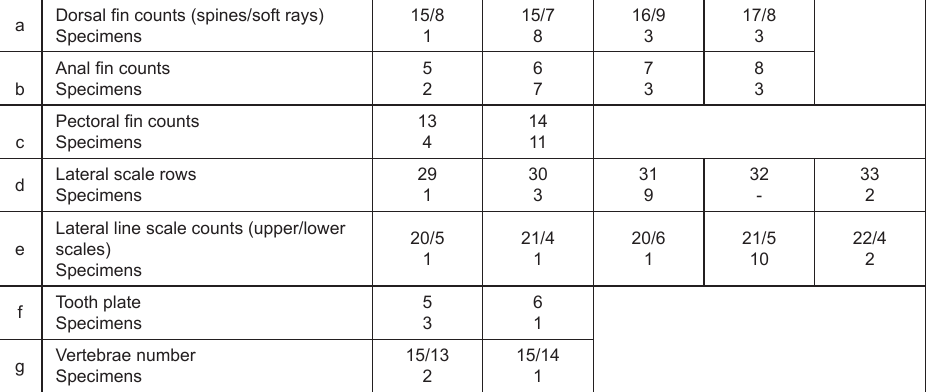
Table 3. Frequency distribution of meristic characters